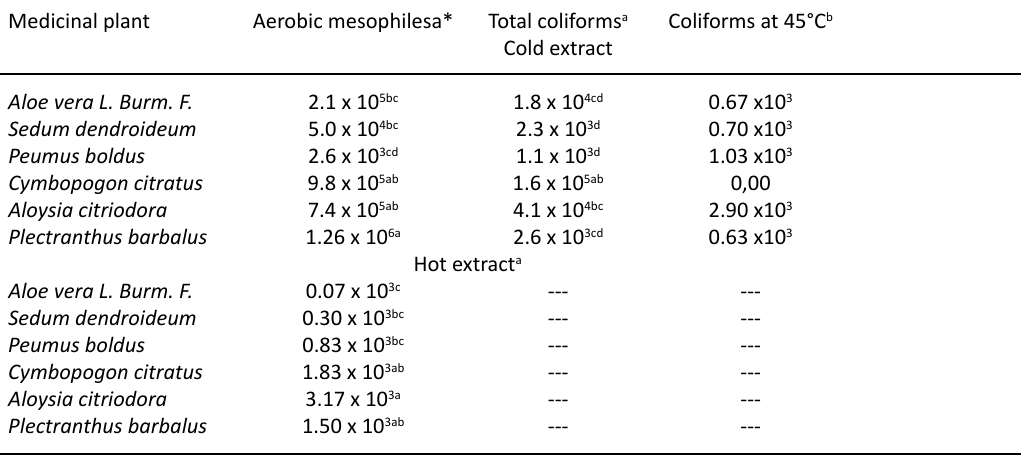
Table 1. Mean of aerobic mesophilus count (CFU/gram), total coliforms (CFU/gram) and coliforms at 45°C (CFU/ gram) of the cold and hot extract of six different plants ( Aloe vera L. Burm. F., Sedum dendroideum, Peumus boldus, Cymbopogon citratus, Aloysia citriodora and Plectranthus barbalus ) collected in a community garden Medicinal